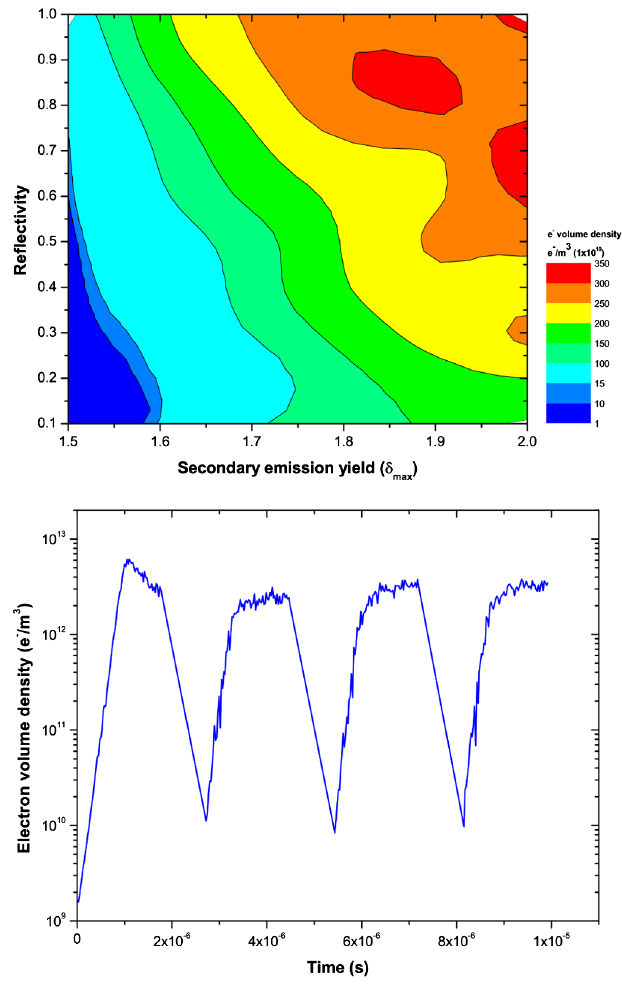
FIG. 28. Top: Contour plot of the electron volume density in a cylinderof1mmradiusaroundthebeaminadipolemagnetforthe case with 25 ns bunch spacing at injection energy. Bottom: Time evolution of the simulated electron volume density (raw simula- ¼ 1 : 8 ). In the top picture the average tion data; R ¼ 0 : 5 , (cid:1) max density computed over the whole simulation time is shown.